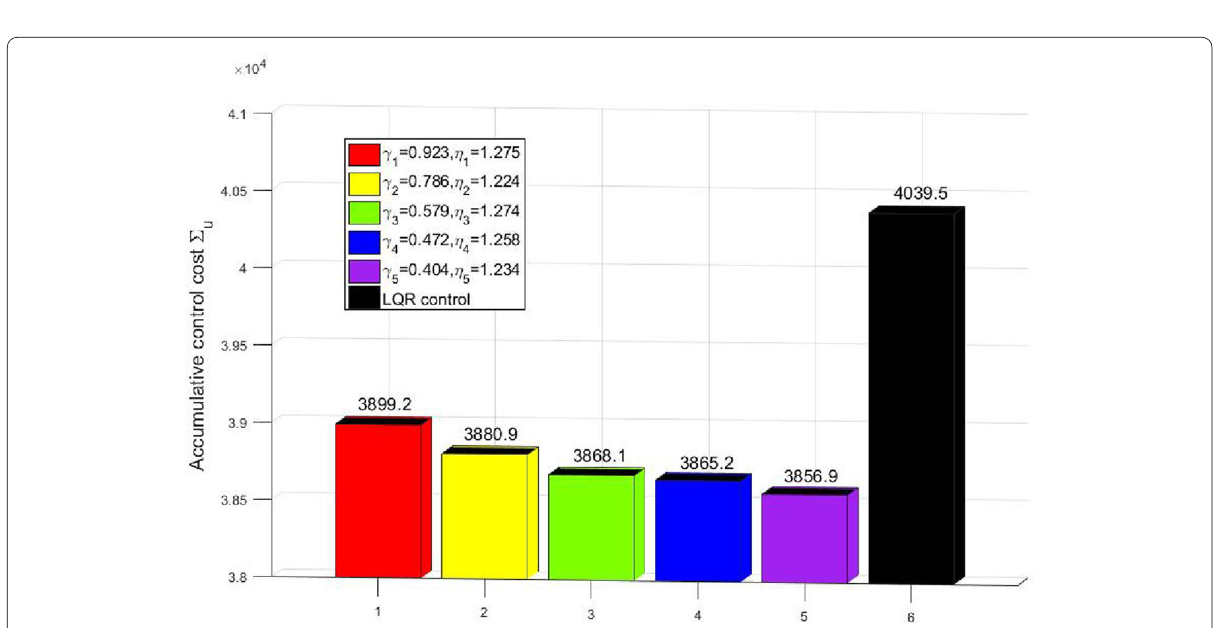
Figure 8 Comparison of accumulative control cost (cid:31)